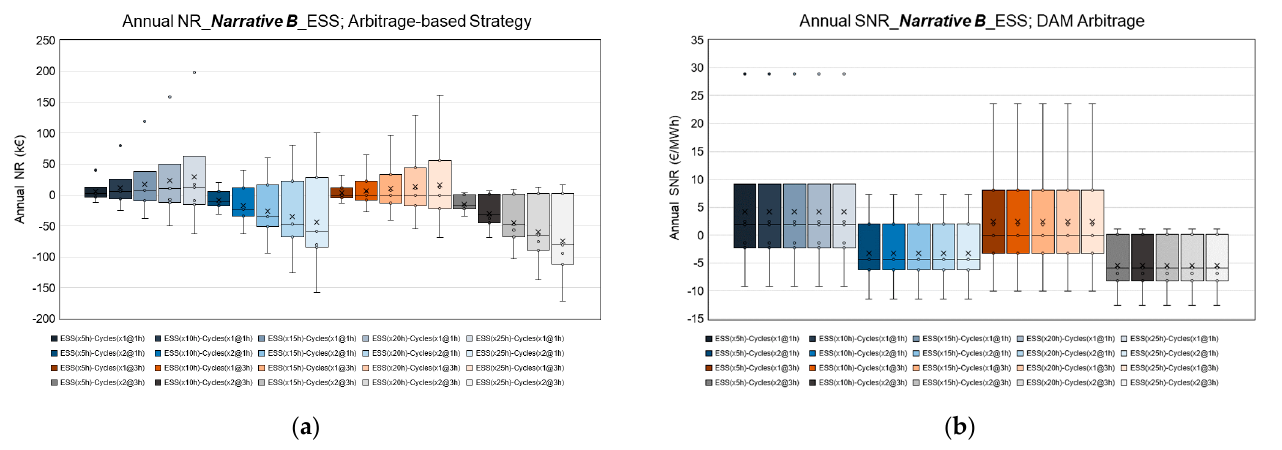
Figure 8. Arbitrage-based market participation of the storage actor; annual NR ( a ) and SNR ( b ) per di ff erent storage con fi guration and cycling option. different storage configuration and cycling